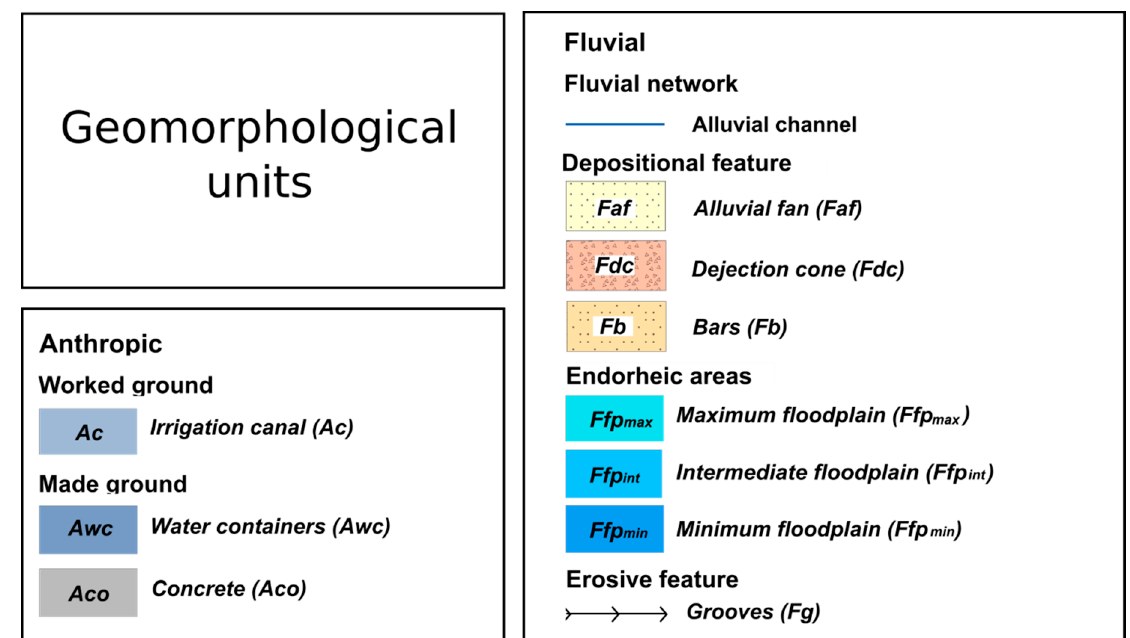
Figure 5. Geomorphological units used in this research work. Table 3. Types of human interventions. Modified from P é rez Cutillas et al.